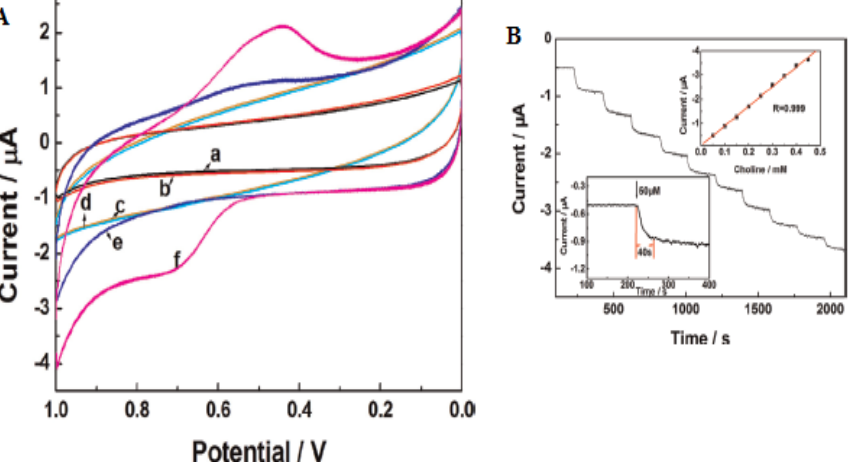
Figure 7. ( A ) Cyclic voltammogram of ( a ) a bare GCE, ( c ) Nafion/ChOx/GCE and ( e ) Nafion/ChOx/MnO 2 /GCE without 0.1mM choline chloride; ( b ) a bare GCE, ( d ) Nafion/ChOx/GCE and ( f ) Nafion/ChOx/MnO 2 /GCE in 0.1 mM choline chloride. ( B ) Amperometric responses obtained upon the successive addition of choline chloride at an applied 0.7 V potential. Each current step corresponds to an increase of 0.05 mM in the choline concentration. The insert in the upper-right corner represents the relationship between the current and choline concentrations (0.008–1.0 mM), while the lower-left corner inset shows the response time. Reprinted with permission from [39].